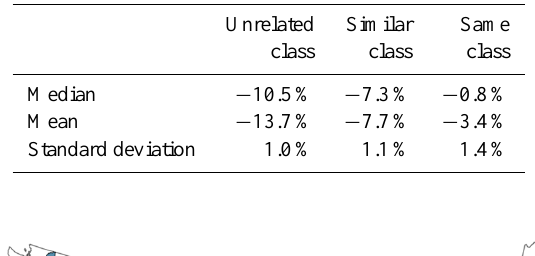
Table 2. Cross-validation results.